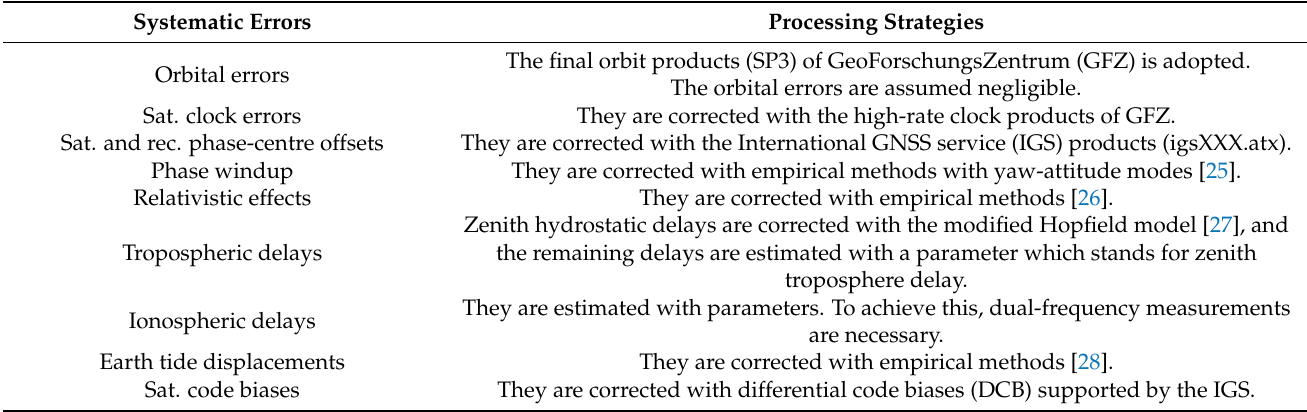
Table 1. Systematic errors and the processing